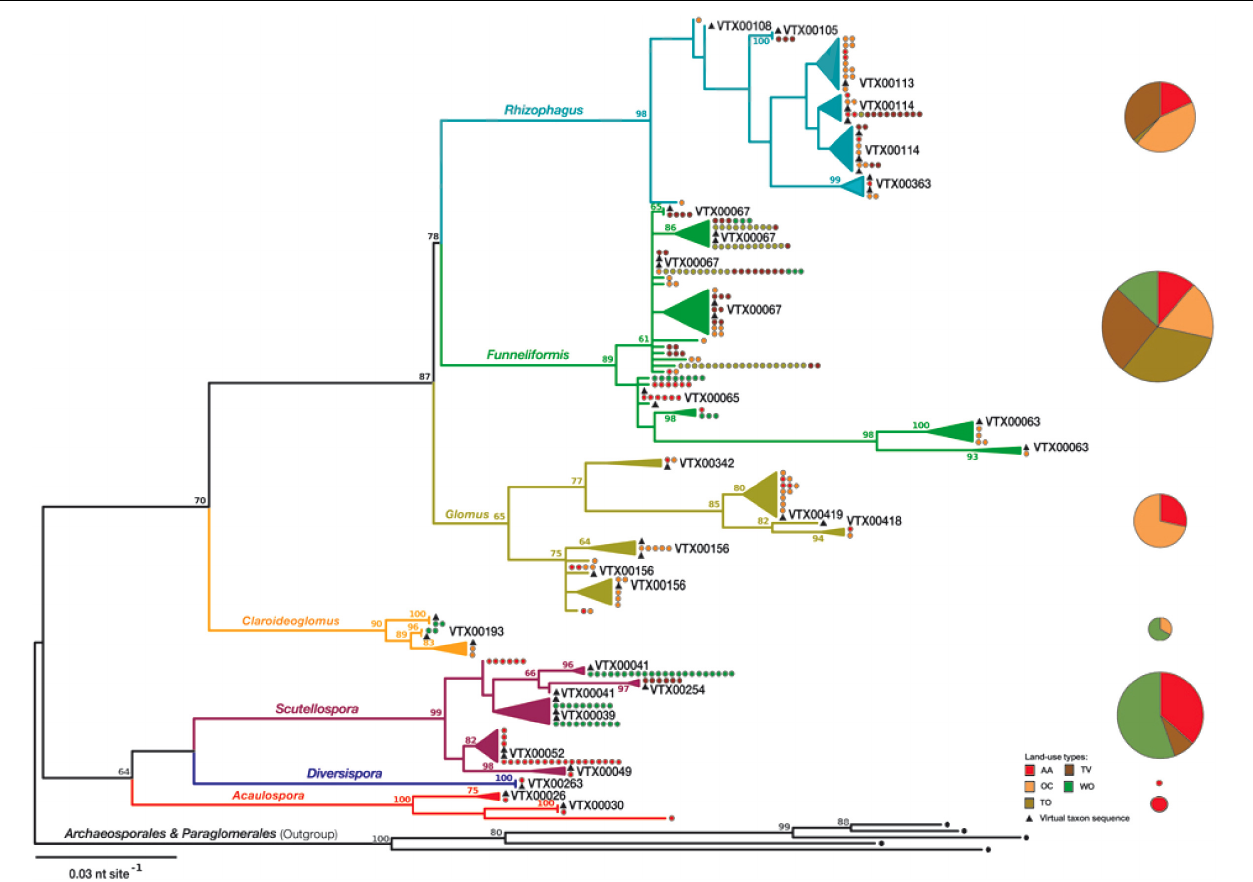
FIGURE 1 | Maximum likelihood (ML) tree to phylogenetically assign the new partial 18S rRNA gene sequences from soil to seven genera of arbuscular mycorrhiza fungi (AMF, phylum Glomeromycota) and accession sequences of Virtual Taxa (VT) of the MaarjAM database (Öpik et al., 2010). The absolute abundance (pie diameter) and relative abundance of the genera in five land-use types (size of pie slices) is indicated at the right [AA, 5 years rotations with 4 years of alfalfa ( Medicago sativa L.)] and 1 year of a winter cereal [durum wheat ( Triticum turgidum L. subsp. durum (Desf.) Husn.) or triticale ( × Triticosecale Wittm. ex A. Camus)]; OC, 3-year rotation with 2 years of oat ( Avena sativa L.) – berseem clover ( Trifolium alexandrinum L.) mixture and 1 year of winter cereal (durum wheat or triticale); TO, tilled olive ( Olea europea L.) orchards; TV, tilled vineyards ( Vitis vinifera L.); WO, woodlands dominated by Quercus cerris L. and Fraxinus ornus L. The tree (GAMMA-based ML: − 4051.61) was constructed with 279 new partial 18S rDNA gene sequences (550 bp, accession numbers: LN714838-LN715116) and phylogenetically closest accessions of VT reference sequences of > 97% identity. The tree is rooted with representative sequences of the five genera of phylogenetically basal AMF orders Archaeosporales and Paraglomerales. Bootstrap values > 60% are shown at the internal nodes of the tree. The number of identical sequences per representative sequence is indicated as dots, whose colors refer to the land-use type from which they were recovered. See Supplementary Figure S2 and Supplementary Table S2 for the accession numbers of the representative and identical sequences and the accession numbers of the phylogenetically closest accessions of